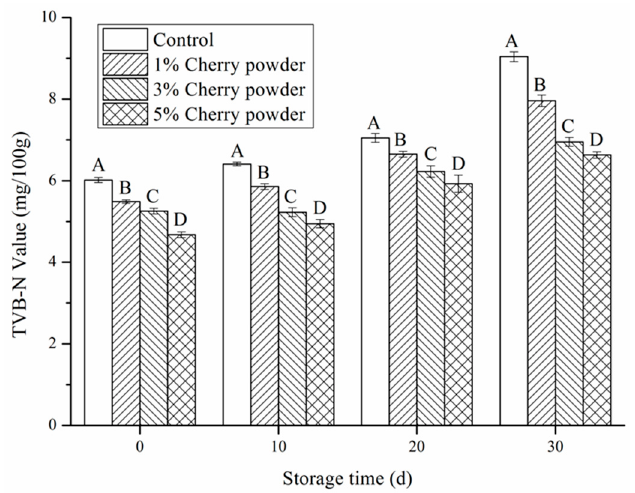
Figure 1. Effects of cherry powder addition on TVB-N values of Jiangsu-type sausage during storage. Note: Different letters (A, B, C, D) indicate a significant difference ( p < 0.05).